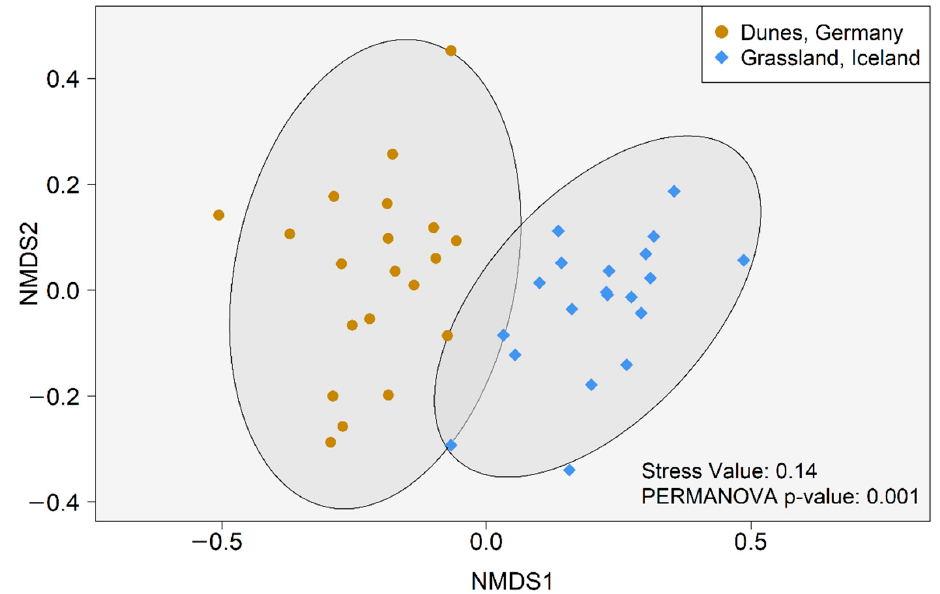
Figure 3. Non-metric multidimensional scaling (NMDS) based on Bray–Curtis dissimilarities among 40 biocrust samples from temperate coastal dunes (Germany) and subarctic grassland (Iceland).